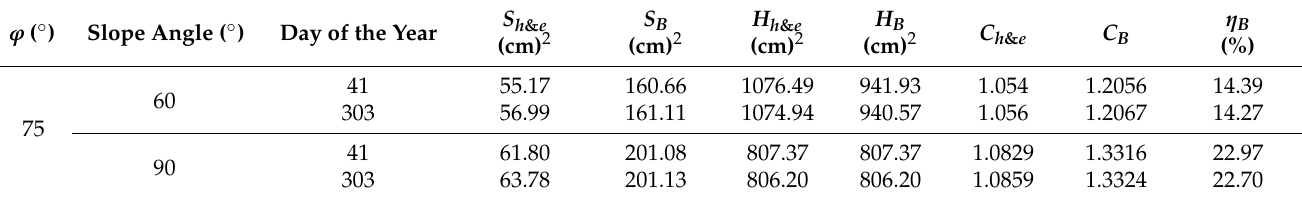
Table 3. Calculated values and comparisons of S , H , C